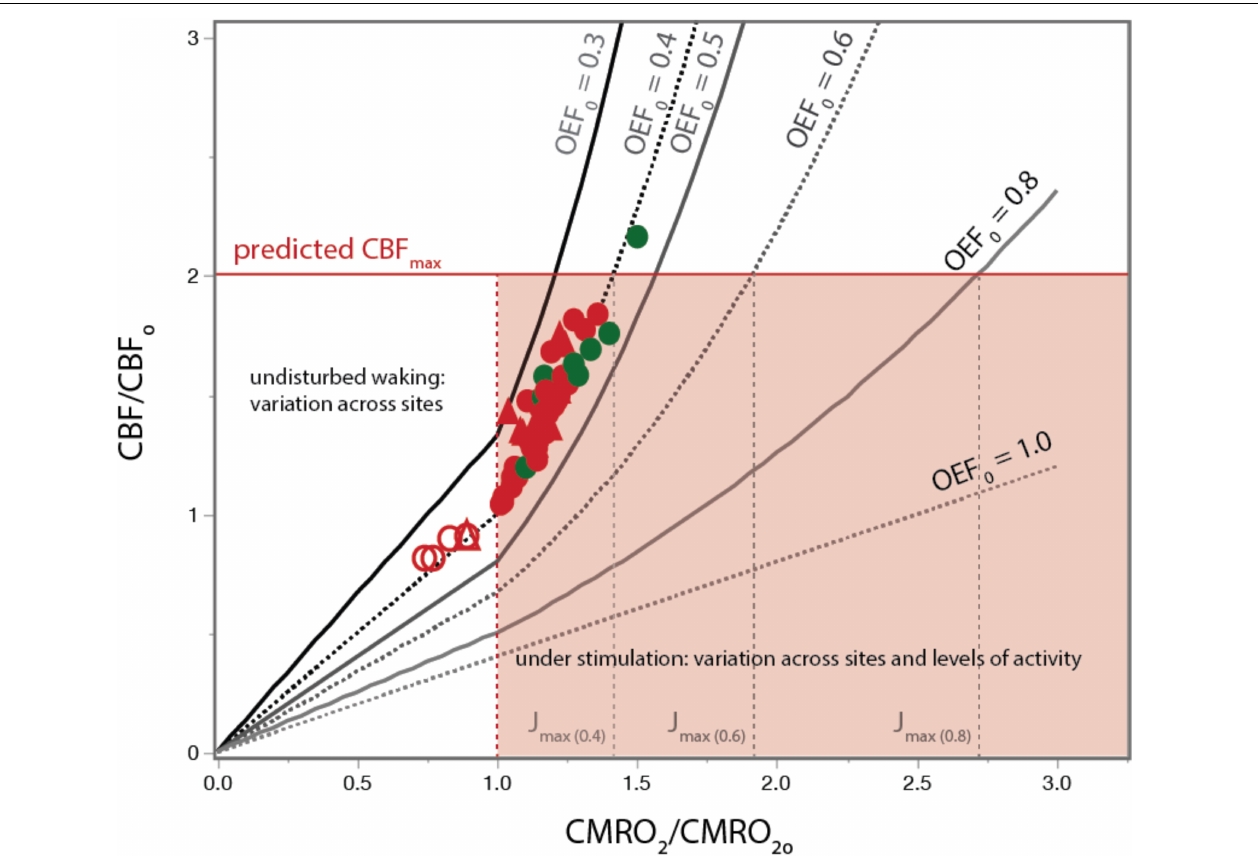
FIGURE 5 | A constant ratio of D O /rCBF O predicts the relationship between rCBF and rCMRO 2 over the full range of cortical brain activity in humans and rats. Red (human) and green (rat) circles show measured values of rCBF normalized to average rCBF o as a function of rCMRO 2 normalized to average rCMRO 2o both in the undisturbed state (straight lines up to CMRO 2 /CMRO 2O ) and during photic stimulation (curved lines, rCMRO 2 /rCMRO 2O > 1.0). Empirical values across states are very well aligned with values predicted by our model using OEF o = 0.4. Using a higher OEF o = 0.5 already underestimates K CBF , and OEF o = 0.3 overestimates it. Solid red line indicates the empirical maximal rCBF/rCBF o ; dotted lines indicate the corresponding predicted values of J max for each OEF o . Data provided in Supplementary Table 4